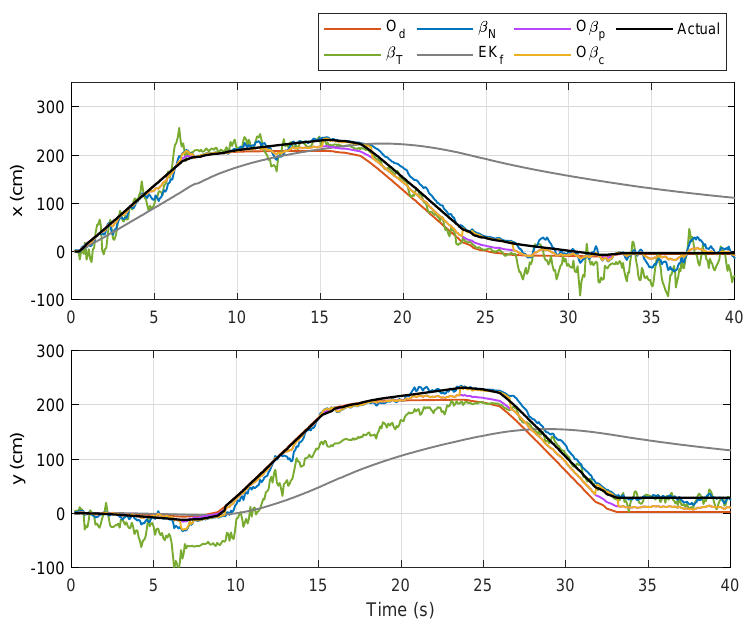
Figure 11. Localization of Node M in x - and y - directions for Trajectory